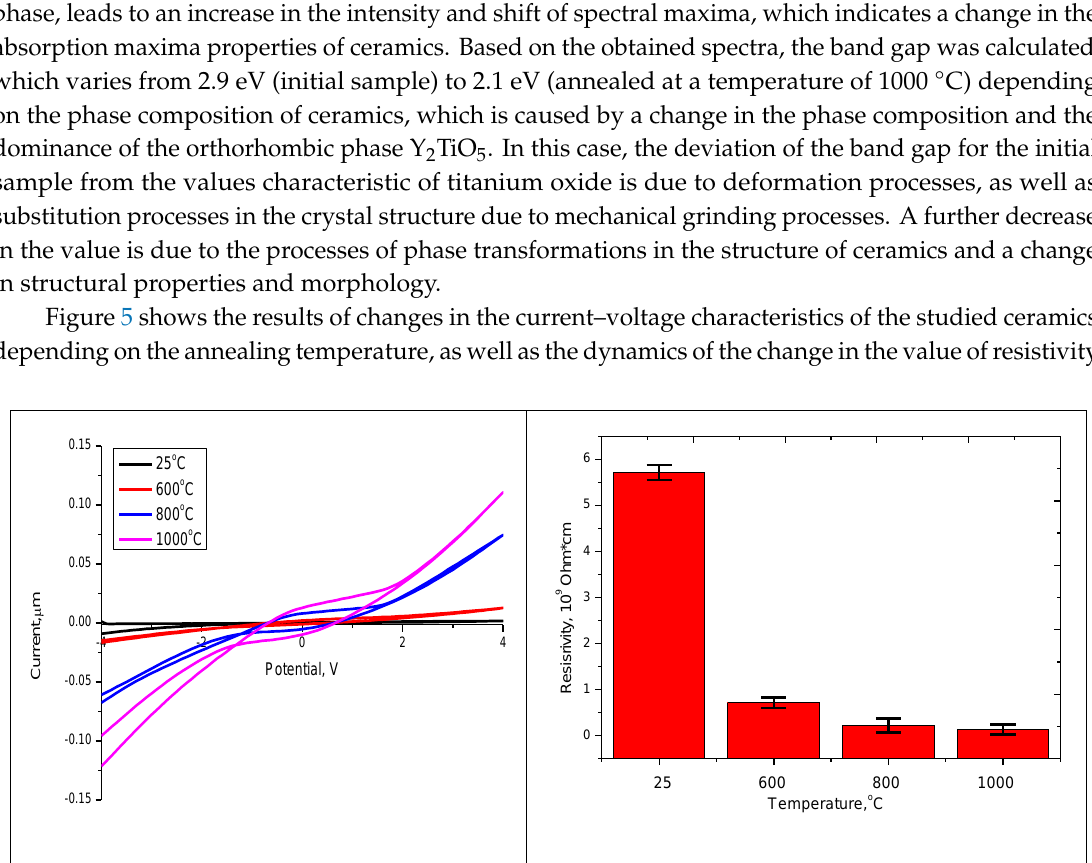
Figure 4. Results of UV spectroscopy of the studied nanostructured ceramics Y 2 O 3 /TiO 2 -Y 2 TiO 5 doped CNTs.